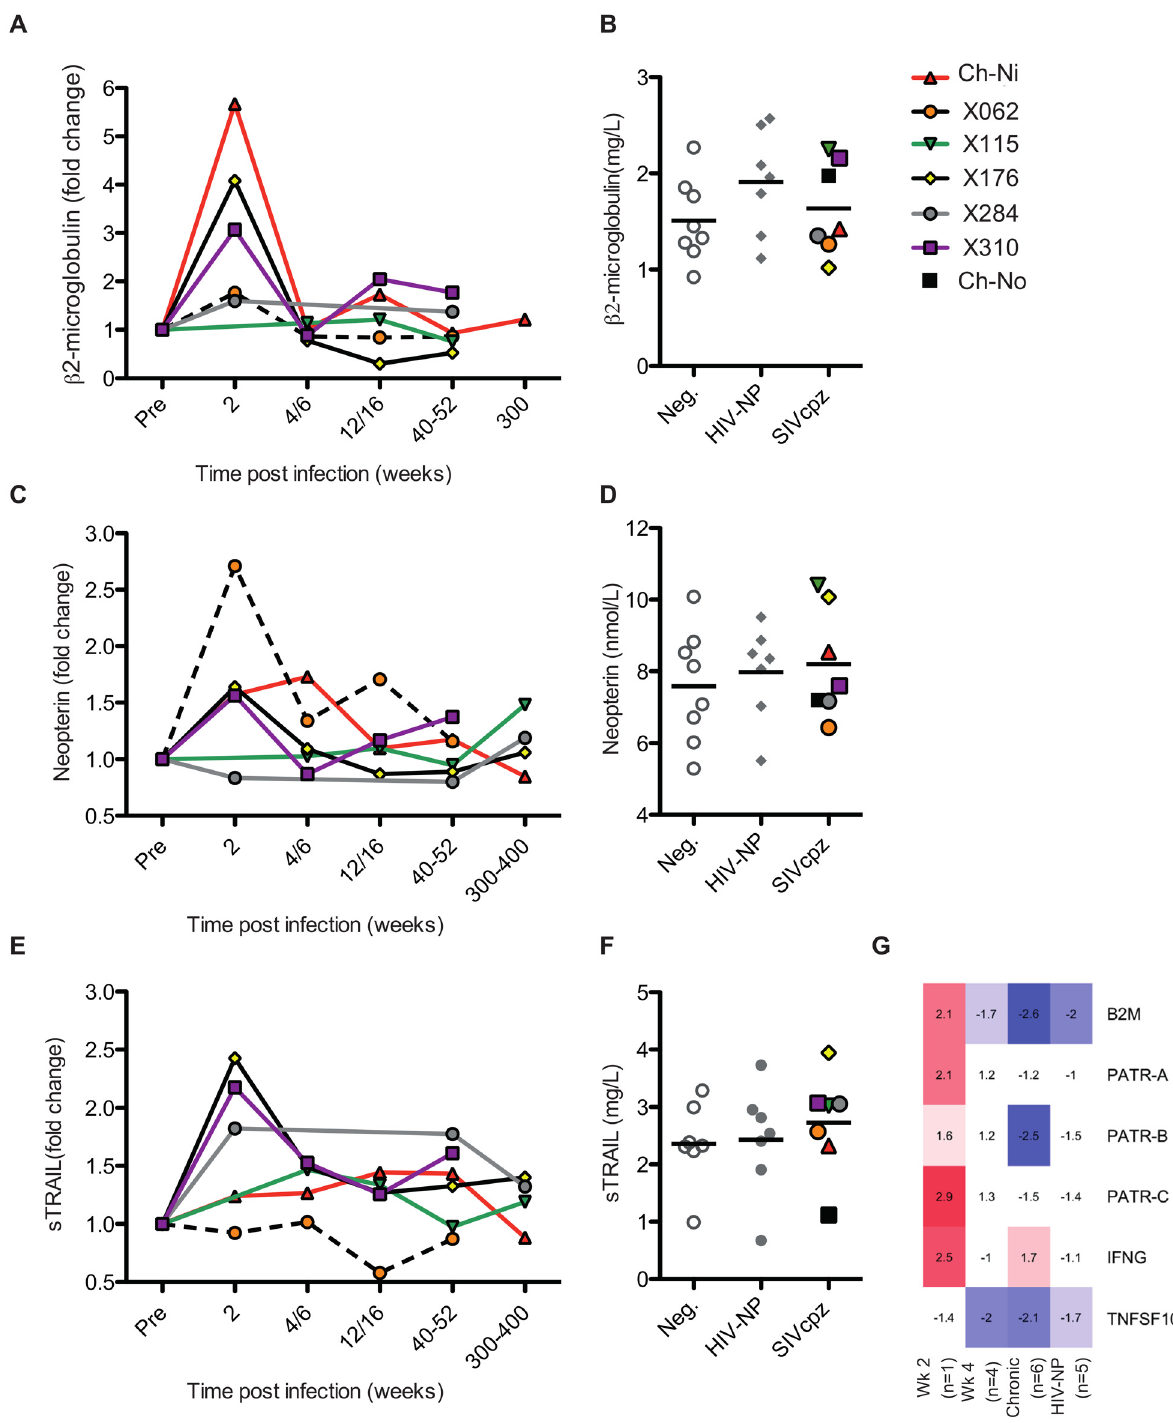
Fig 3. Soluble markers of immune activation in the plasma of SIVcpz infected chimpanzees. (A, C, E) Plasma levels of β 2-microglublin, neopterin, and sTRAIL determined by ELISA, during the acute and chronic phase of infection in the experimentally infected animals. Levels of each marker were normalised to the pre-infection level for each animal. Horizontal black bars indicate the mean value in each group. As sampling times and/or sample availability was not identical for each animal, comparable time points are grouped (e.g. week 4 and week 6 are displayed as a single time point). (B, D, F) Levels of each marker in the chronic phase (including Ch-No) of SIVcpz infection compared with values for uninfected and HIV-1 infected chimpanzees, and displayed as absolute values. (G) Heatmap showing expression levels of the indicated genes in RNA-seq transcriptomics analysis of PBMCs.